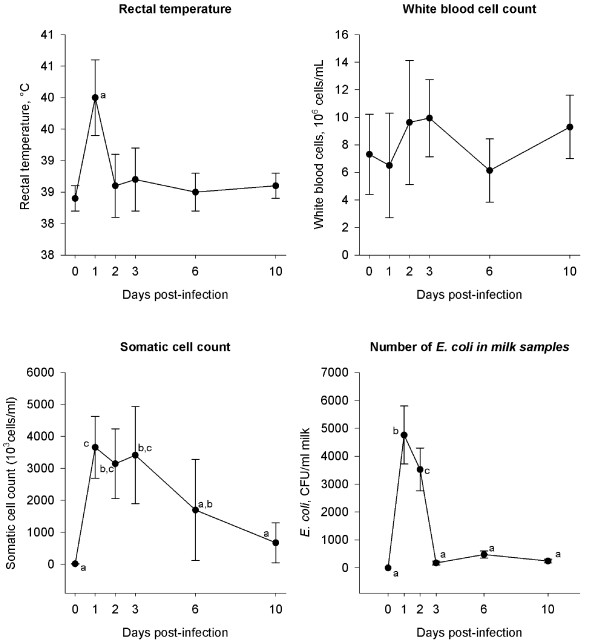
The development of rectal temperature, white blood cells, somatic cell count and number of E. coli bacteria. From one day before (day 0) until 10 days after inoculation with Escherichia coli into the udder of 7 dairy cows. Plots with different letters differ significantly. Error bars show SE.